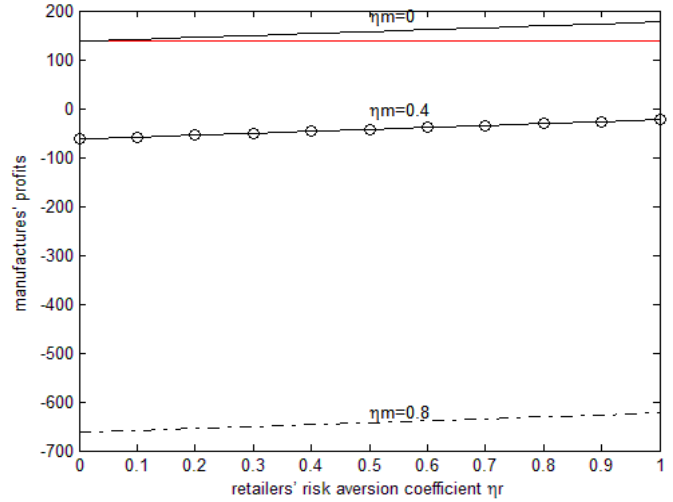
Figure 4. The effects of the risk aversion coefficient on the manufacturer’s profits.